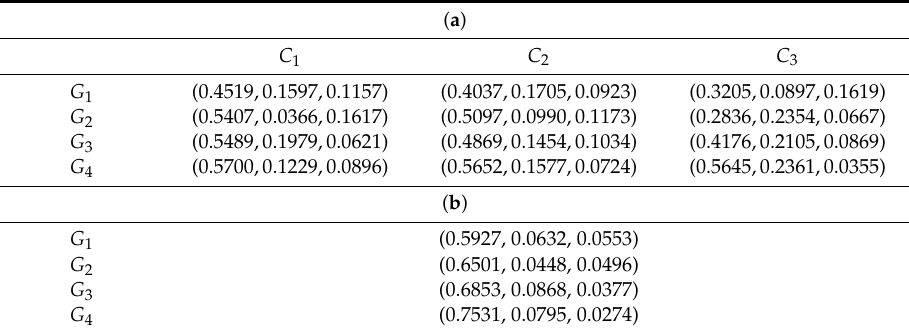
Table 12. ( a ) Ordered collective picture fuzzy information. ( b ) Aggregated information.